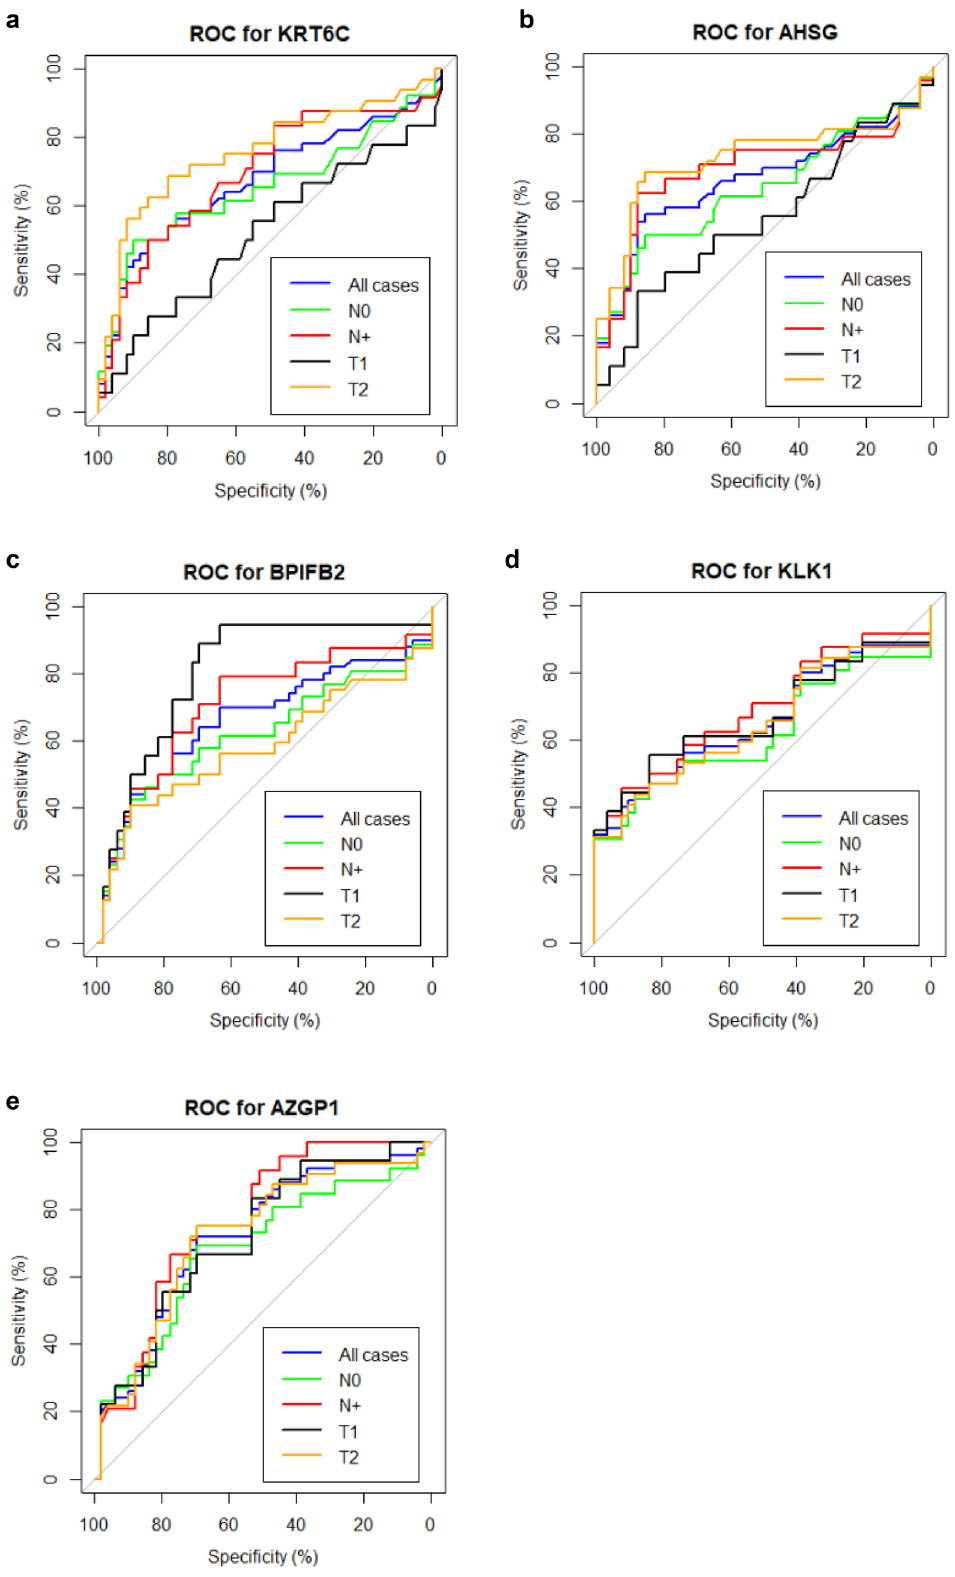
Figure 5. ROC curve for significantly dysregulated proteins (a) KRT6C ( b ) AHSG ( c ) BPIFB2 ( d ) KLK1 and ( e ) AHSG. Characteristics of the curves are mentioned in Table